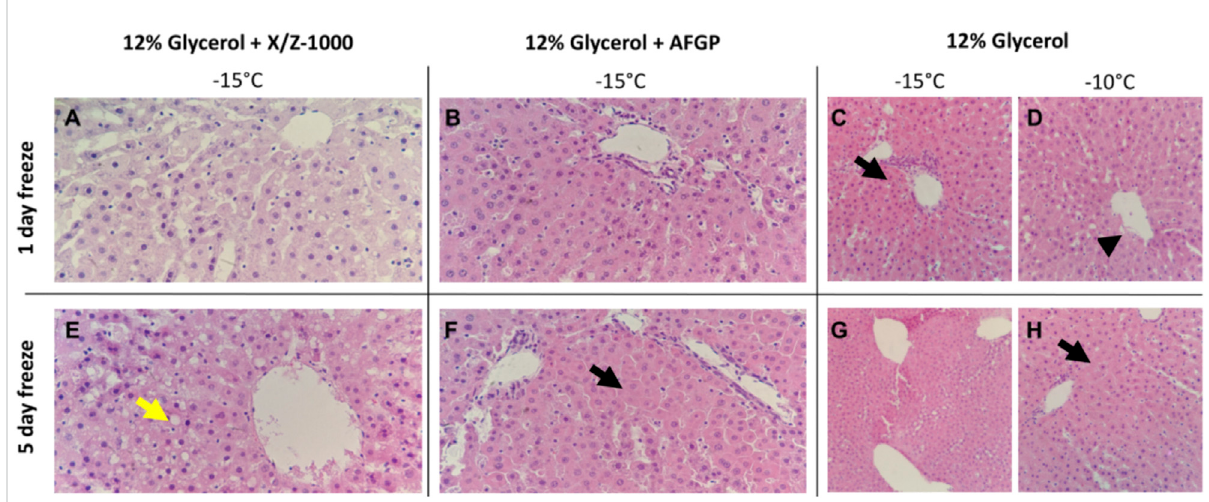
FIGURE 4 H&E staining of rat liver parenchyma after partial freezing for 1 day (A – D) and 5 days, (E – H) with X/Z-1000, AFGP ice modulators versus 12% glycerol only (40X). Yellow arrow indicates intracytoplasmic vacuoles. Black arrows indicate hepatocyte swelling and compressed sinusoids. Arrowhead indicates endothelial cell